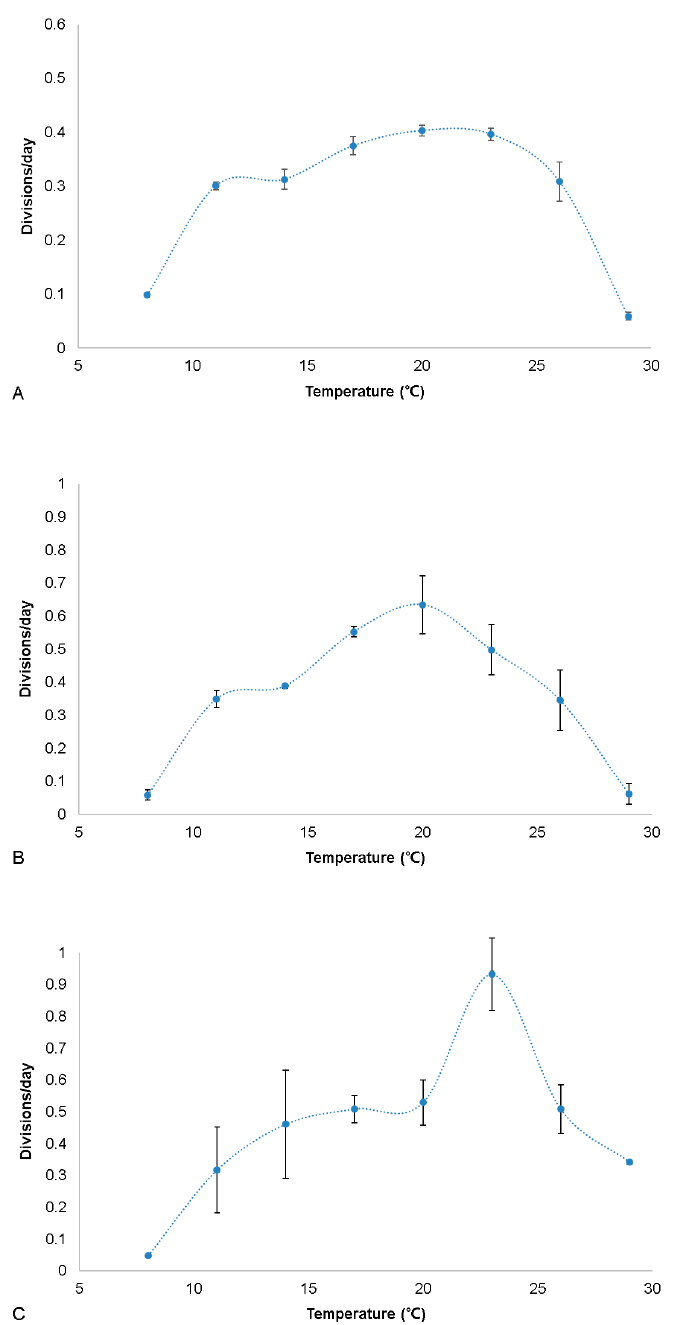
Figure 7. Growth responses of Alexandrium pacificum to various temperatures. ( A ) Strain TIO855 from the Yellow Sea, ( B ) strain ATDH46 from the East China Sea, and ( C ) strain TIO866 from the South China Sea. The values refer to mean divisions day − 1 and the error bars refer to standard devi- ations.